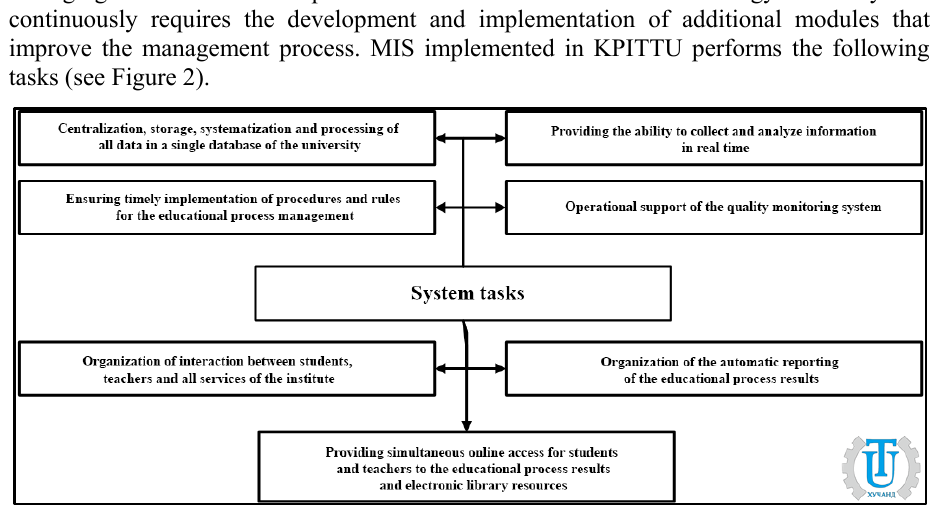
Fig. 2. Tasks of management information